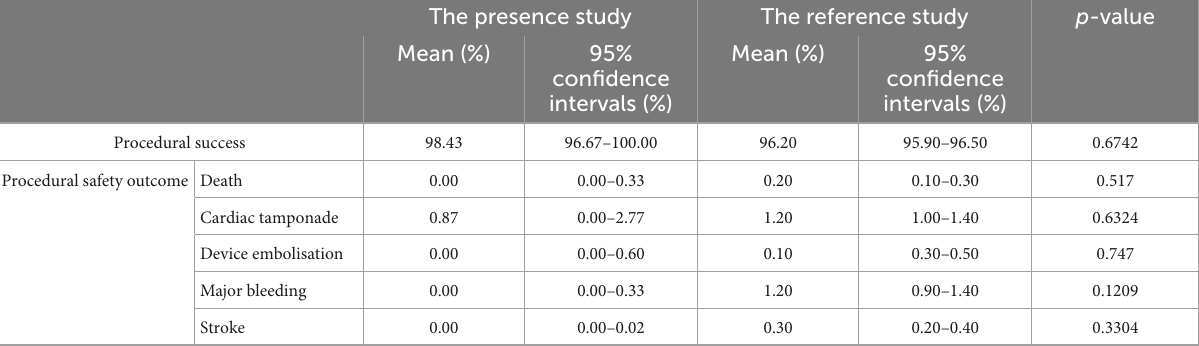
TABLE 2 Subgroup analyses of procedural feasibility and safety outcome.